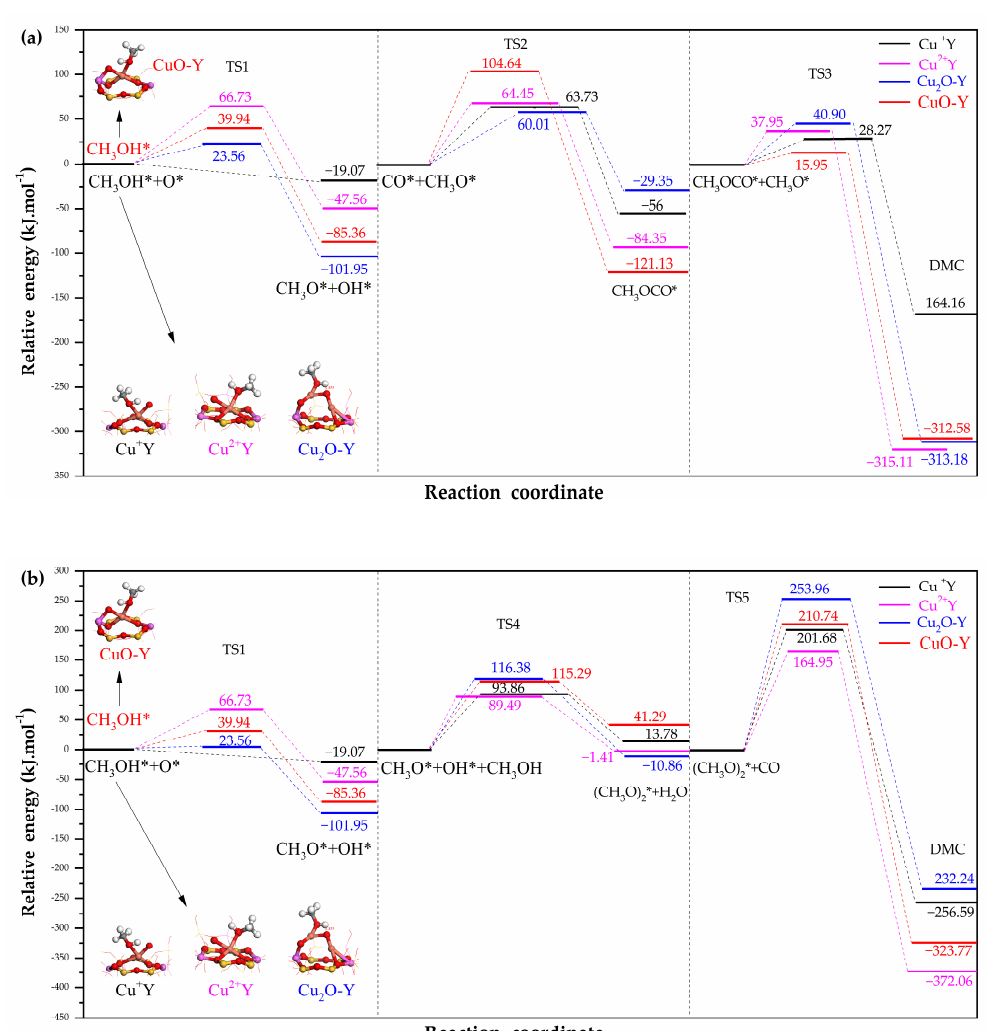
Figure 10. The reaction mechanism for the formation of DMC over Cu + Y, Cu 2+ Y, Cu 2 O-Y and CuO-Y zeolites via path I ( a ) and path II ( b ).